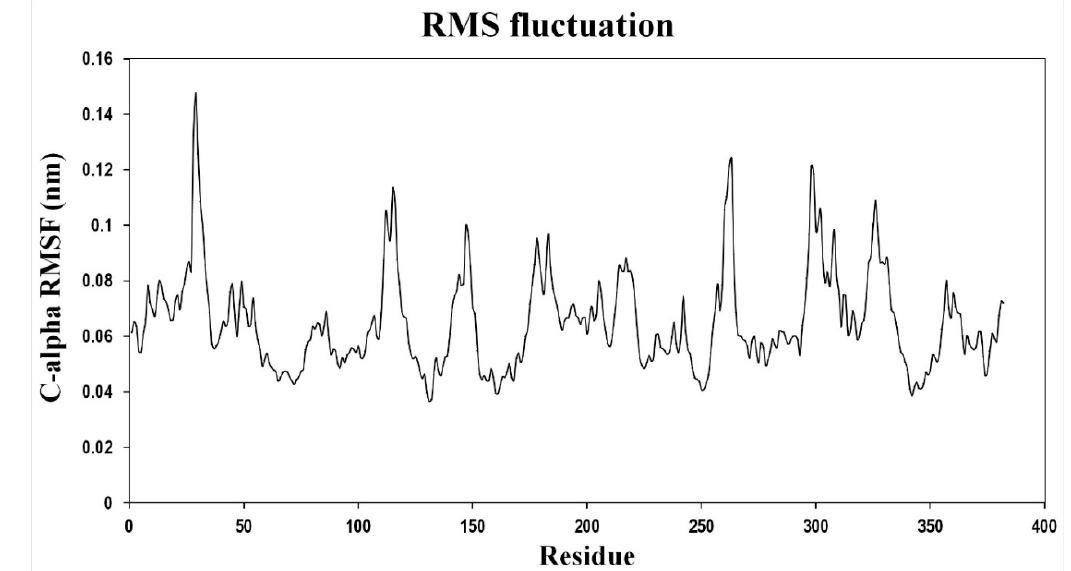
Figure A1. The root-mean-square fluctuations (RMSFs) of the backbone C-alpha coordinates are shown as a function of residue number over the 11 ns simulation. Residues 90–109, 129–142, 307–317, and 333–342 are located in the TMS IV, V, XI, and XII respectively. Residues 187–212 and 226–241 are located in the TMS VII and VIII respectively. All the other residues showing significant fluctuations are present in the loop regions. TMSs IV, V, XI, and XII form the core domain, whereas TMSs VII and VIII are a part of the dimerization domain.